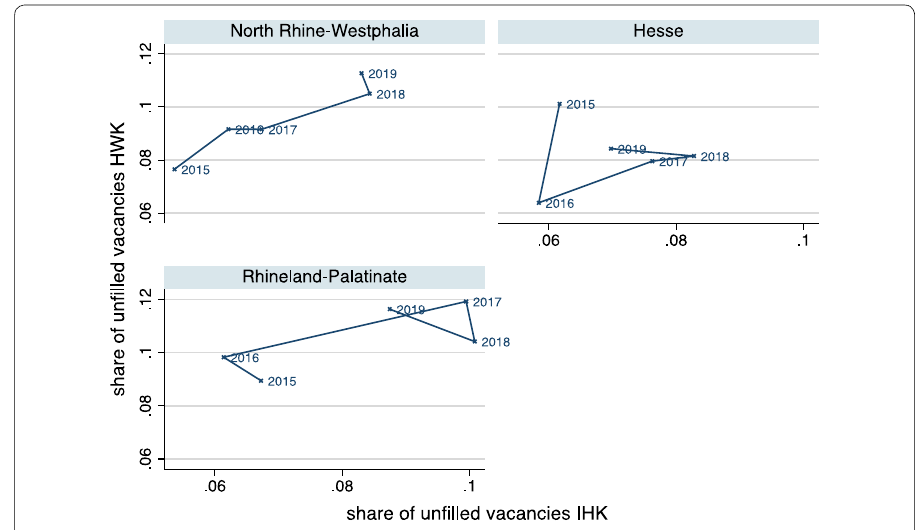
Fig. 13 Share of unfilled vacancies in craft (HWK) and industry and trade (IHK) for West German states, 2015– 2019. Data sources: Vocational training statistics of the statistical offices of the federal and state governments